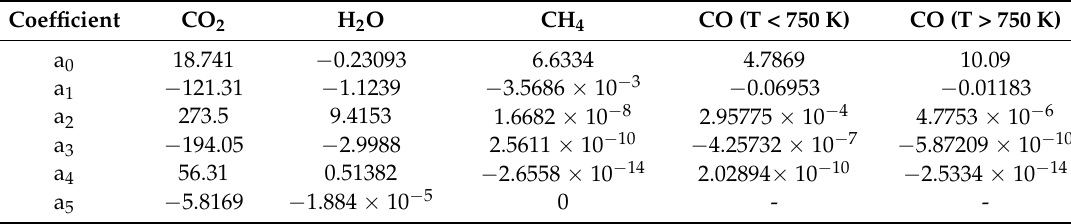
Table 2. Absorption coefficient of a 0 to a 5 for CH 4 , CO, CO 2 , and H 2